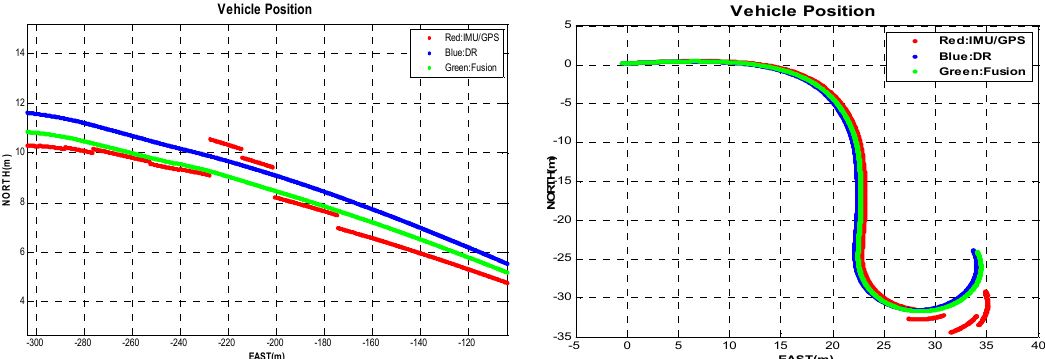
Figure 9. The data fusion results when interrupted GPS–IMU signals are present for straight roads ( Left ) and curved roads ( Right ).